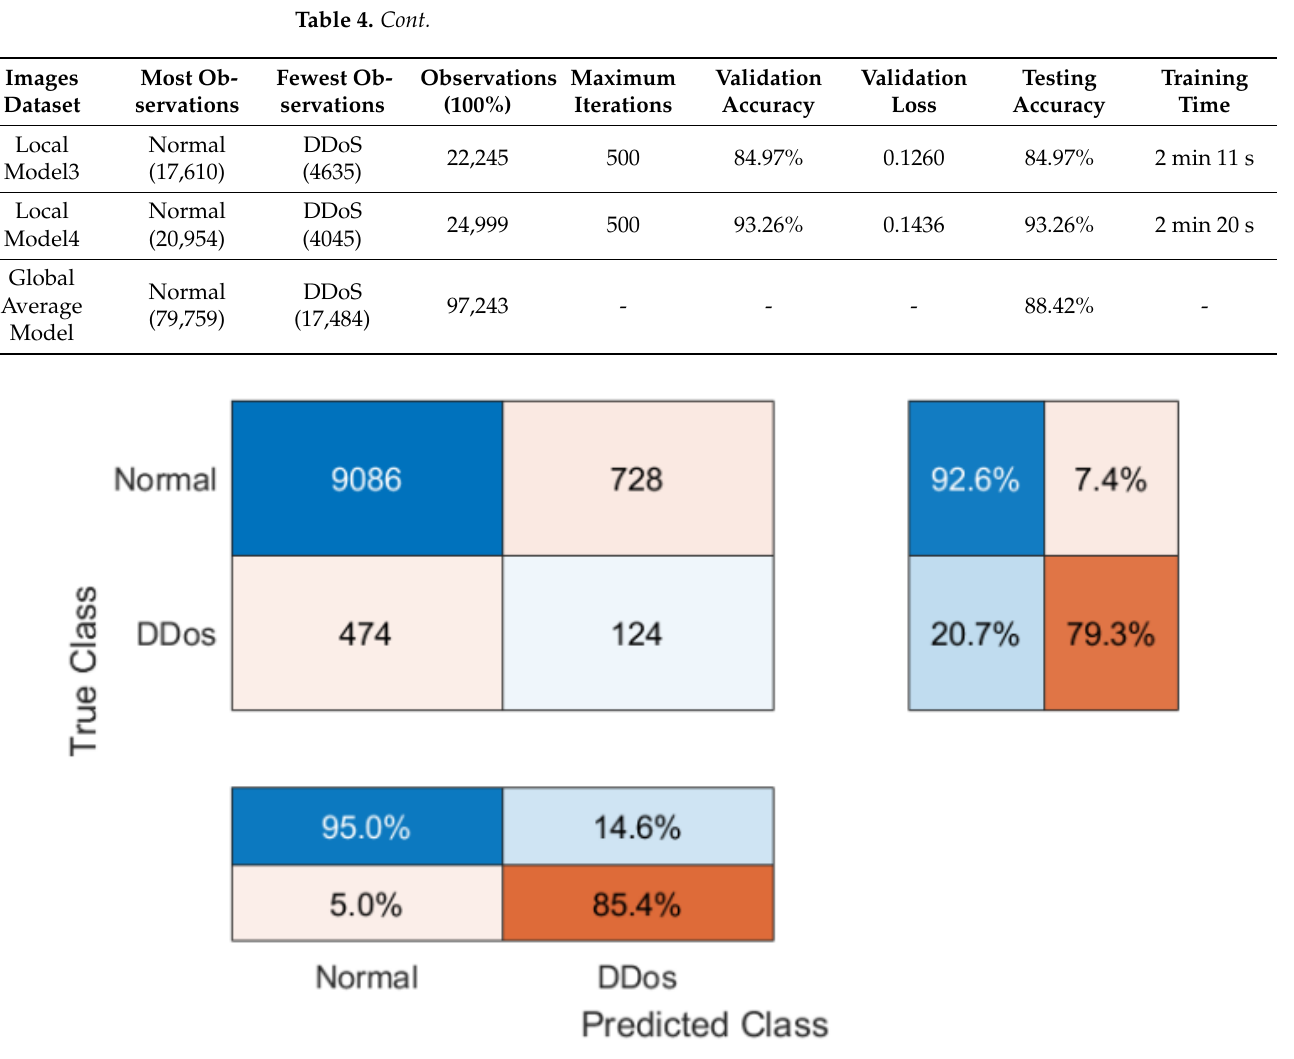
Figure 18. Confusion matrix visualizing the performance testing of the averaged Global Model.